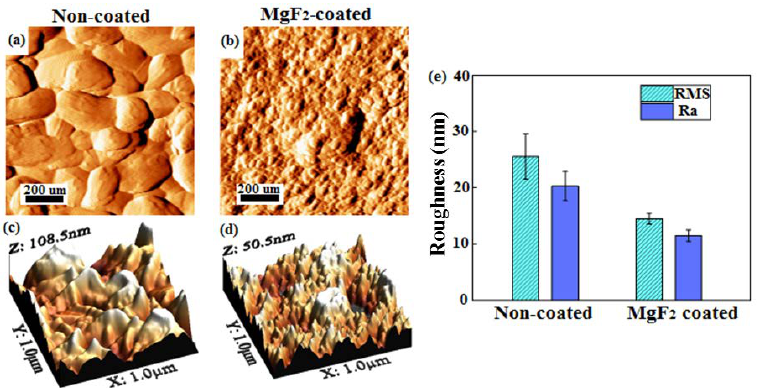
Figure 6. AFM analysis performed on screws head: 2D images of non-coated ( a ) and coated ( b ) screws; 3D-images of non-coated ( c ) and coated ( d ) screws; roughness measurements ( e ).